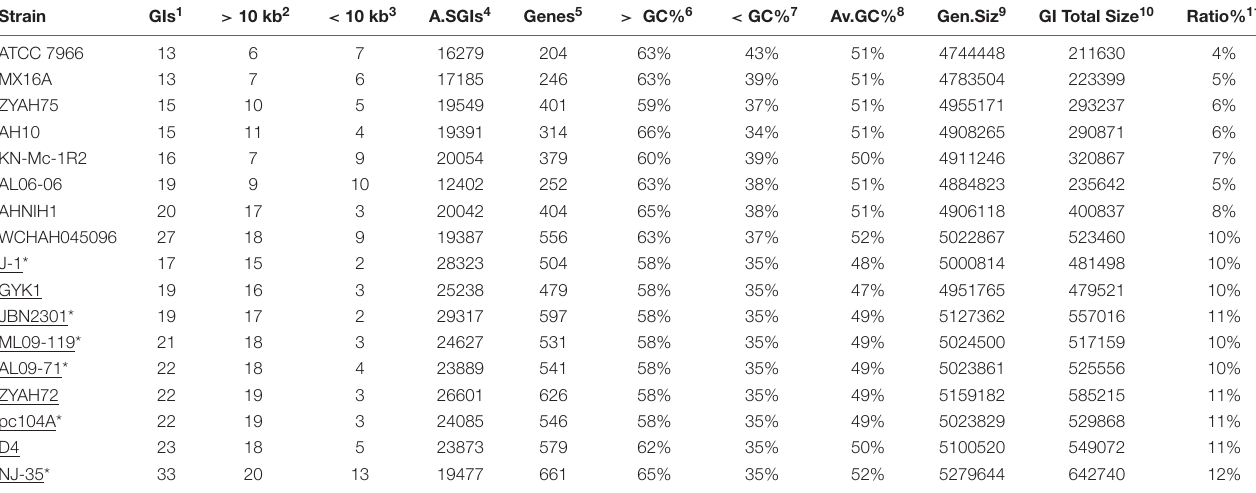
TABLE 2 | General data of predicted genomic islands